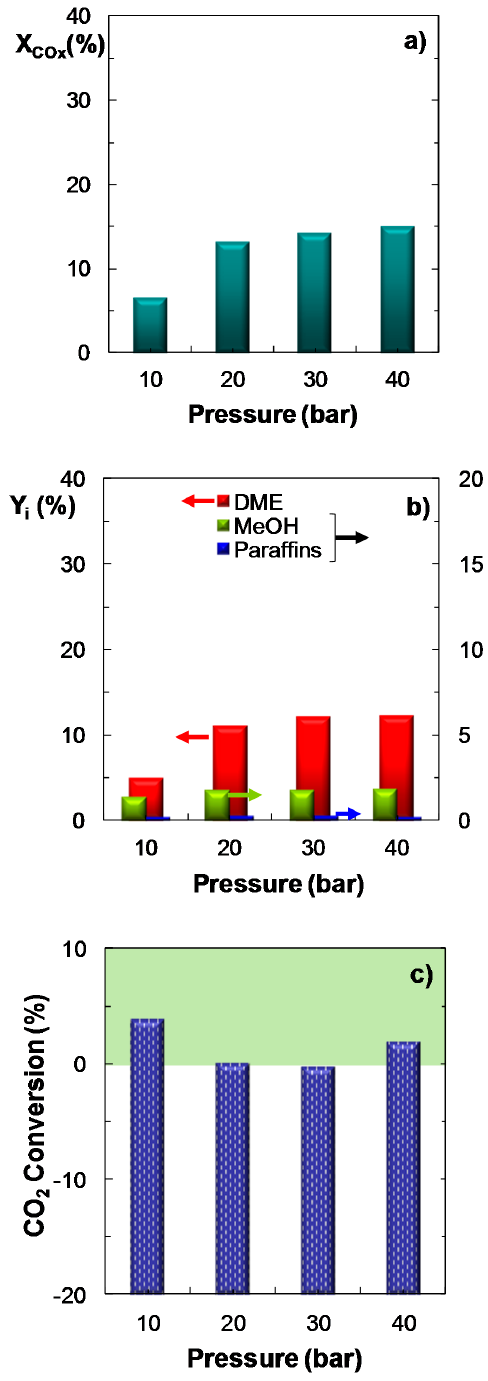
Figure 3. Effect of pressure on the conversion of CO x ; ( a ) Product yield; ( b ) CO 2 conversion (or CO 2 yield, for negative values); ( c ). Reaction conditions: Feed, H 2 + CO + CO 2 with H 2 /CO x molar ratio of 3, and CO 2 /CO molar ratio of 2/3; 275 °C; 10 g cat h (mol C ) − 1 .